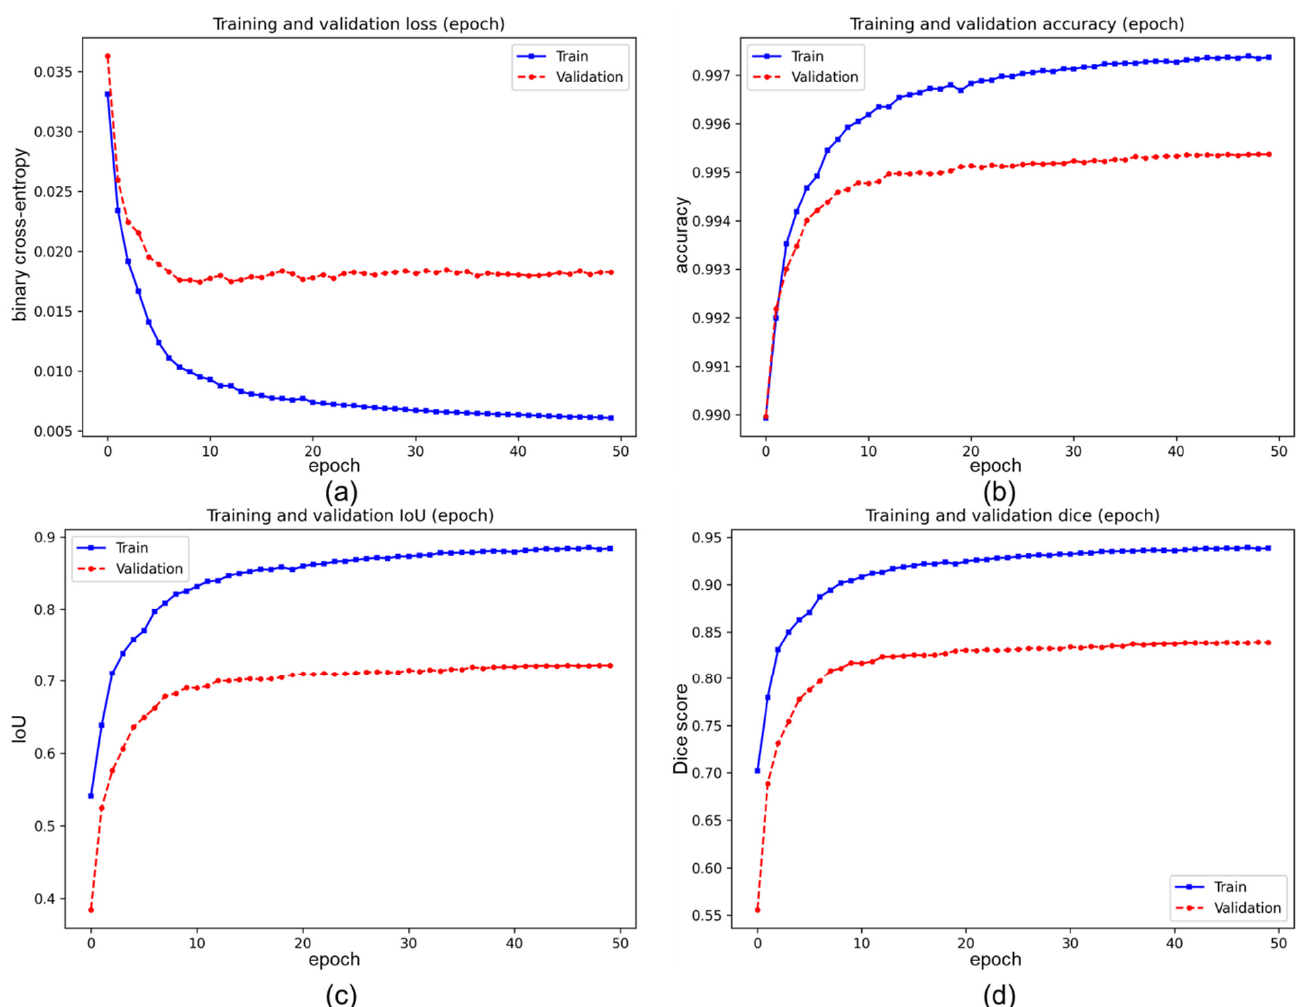
Figure 10. The transfer training curves using the “Annotation-2” dataset. ( a – d ) refer to the transfer training curves of the loss, accuracy, IoU, and Dice score, respectively. The blue solid curves and red dash curves refer to the training records from the training and validation sets.